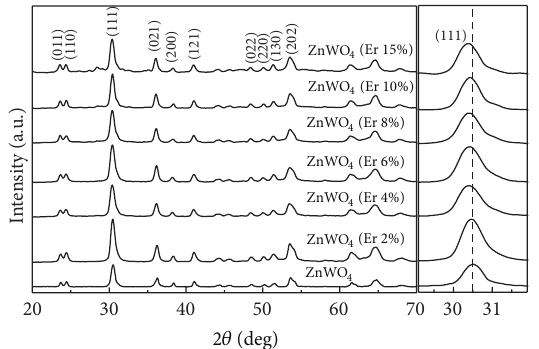
Figure1:XRDpatternsofZnWO 4 andEr 3+ -dopedZnWO 4 samples.